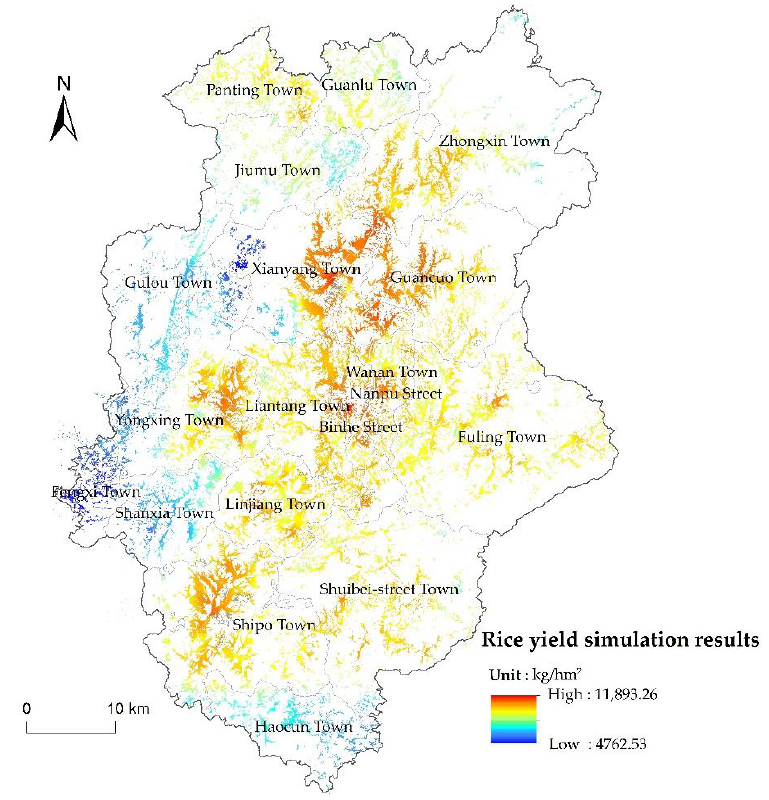
Figure 4. Simulated rice yield results on cultivated land in Pucheng County.